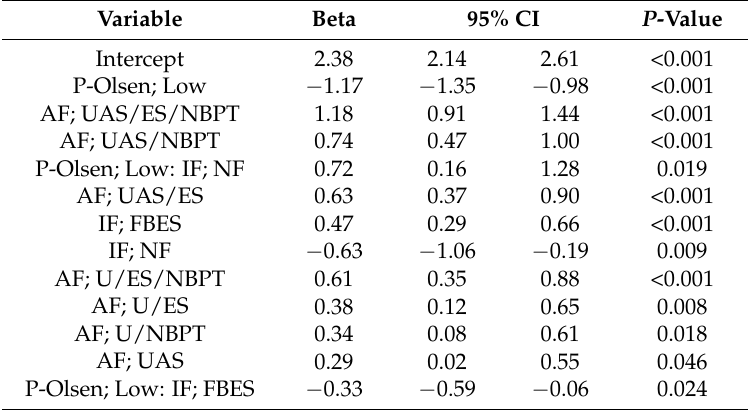
Table 5. Regression coefficients (95% confidence intervals) and p -values for the selected model. (IF, initial fertilization; AF, additional fertilization; NF, no